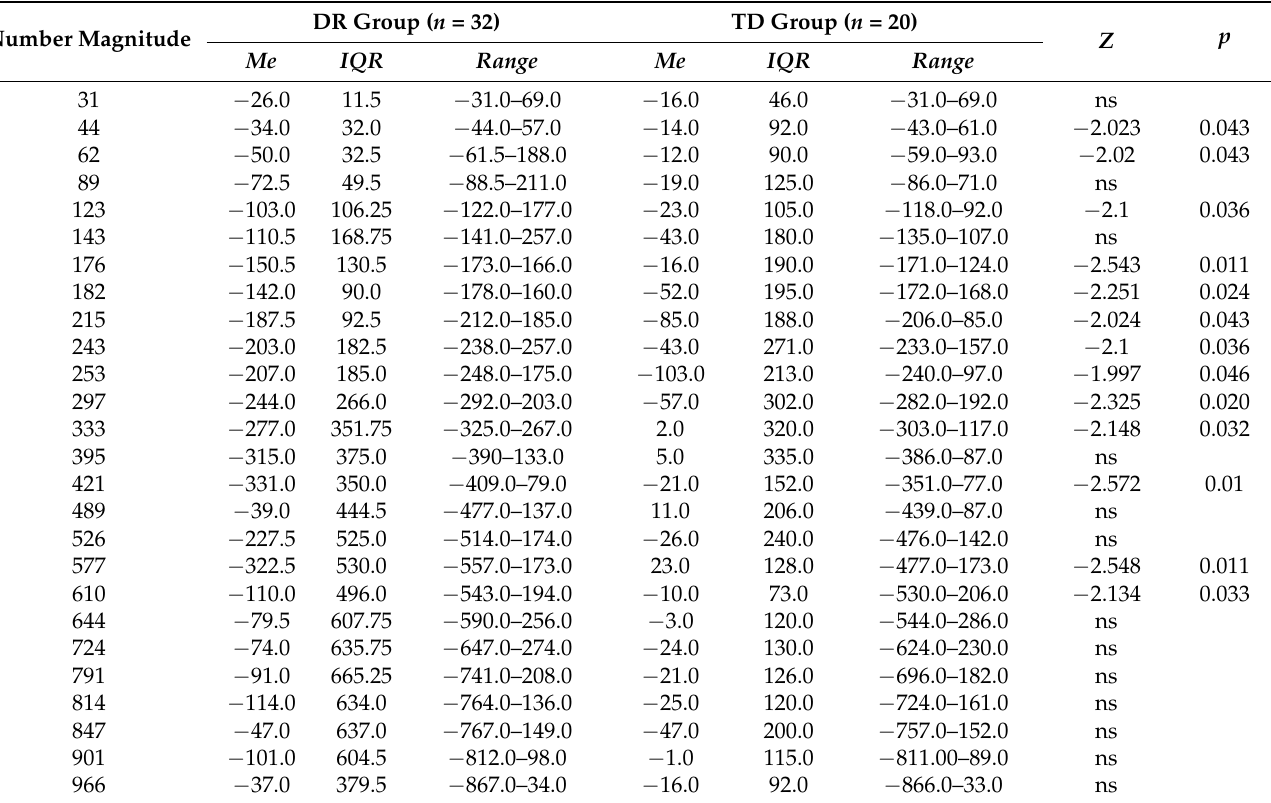
Table 4. Descriptive statistics (median, IQR, and range) calculated for each particular number used in task 2 (0–1000 number line) obtained in the DR and TD